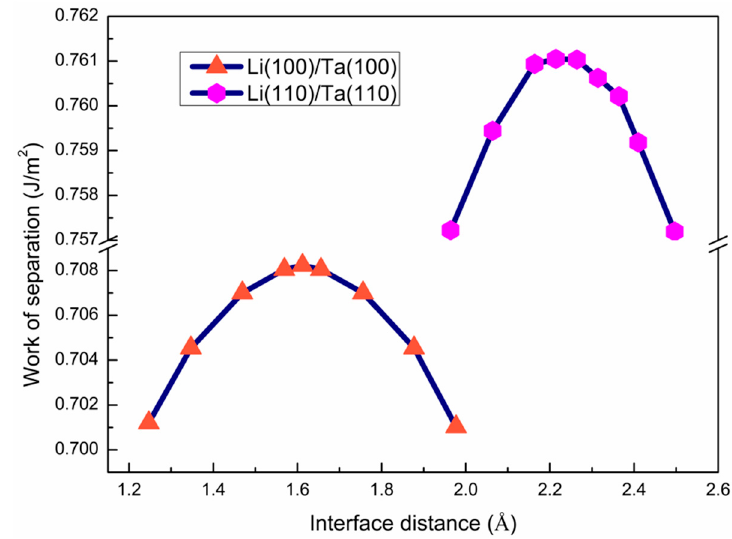
Figure 2. The W sep as a function of the initial interface distance (d 0 ) in both Li(100) / Ta(100) and Li(110) / Ta(110) bilayers.